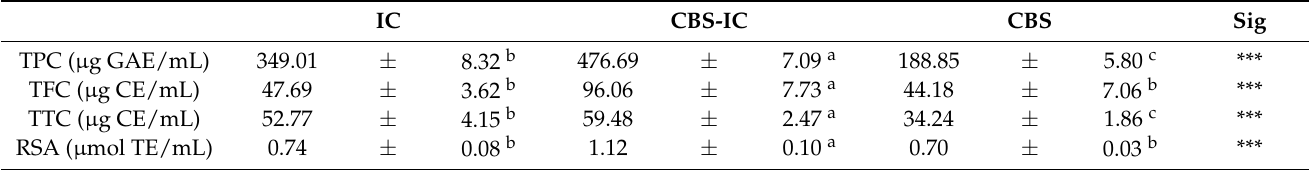
Table 3. Total phenolic, flavonoid, and tannin content and antioxidant capacity in IC, CBS-IC, and